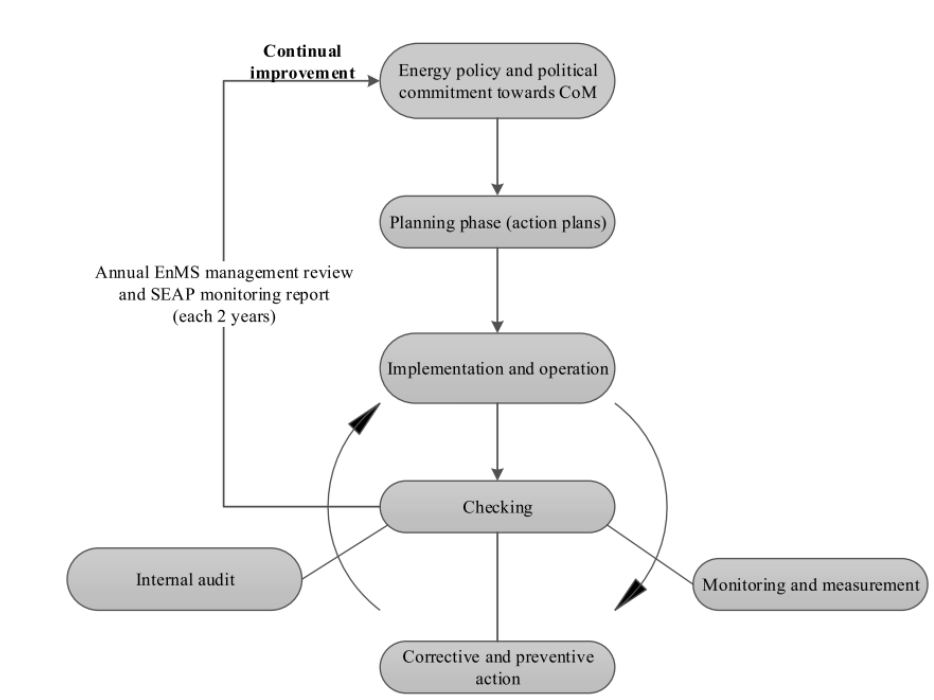
Fig 1. Methodology of the integrated EnMS and SECAP approach